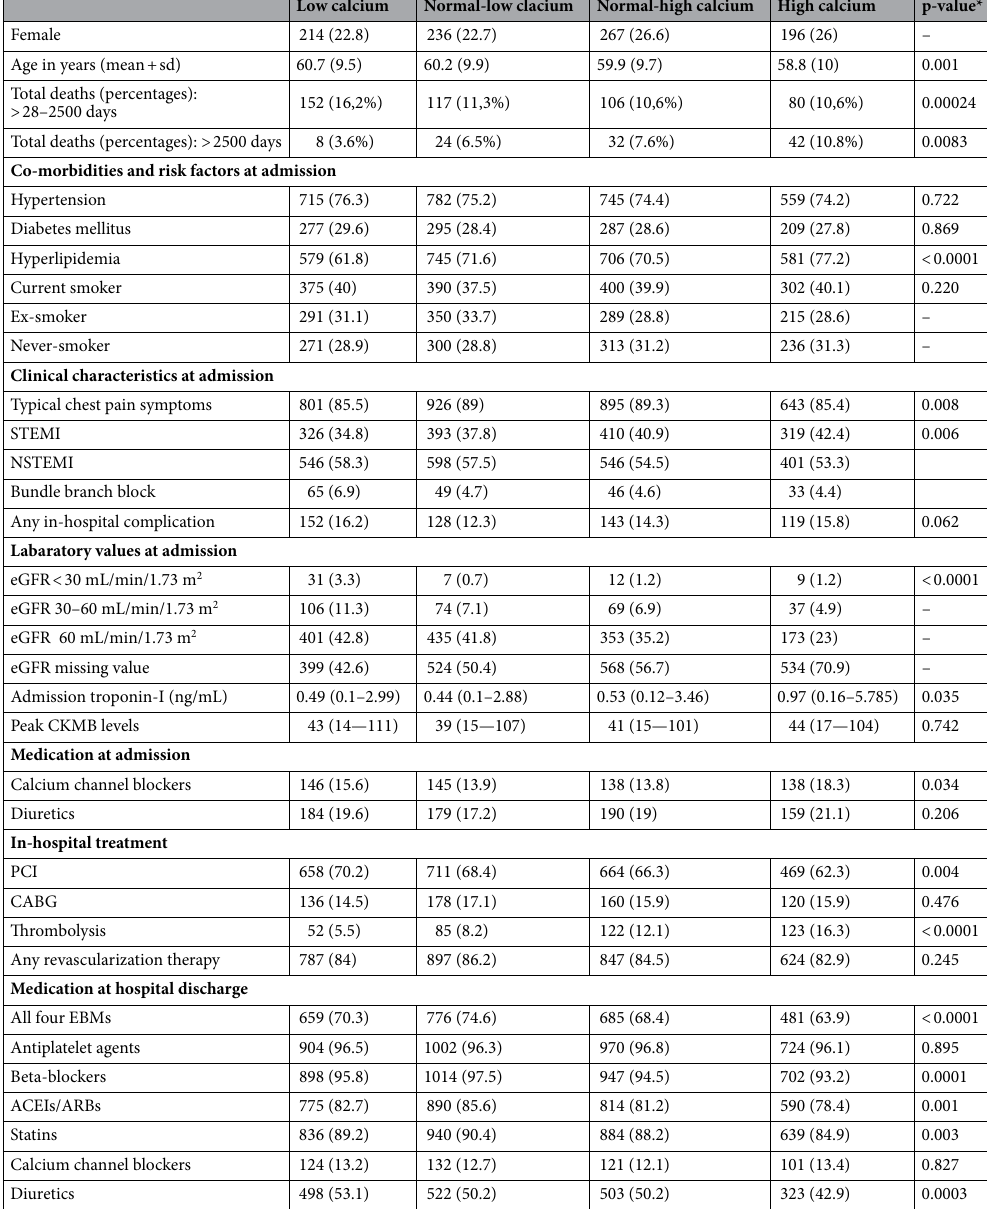
Table 1. Baseline characteristics of AMI patients (n = 3732) by admission total serum calcium. Categorical data presented as total numbers and % (proportion within each calcium group). Numeric data presented as median and (IQR). *Chi 2 test was applied for categorical variables and ANOVA (analysis of variance) was applied for continuous variables. P values < 0.05 are considered statistically